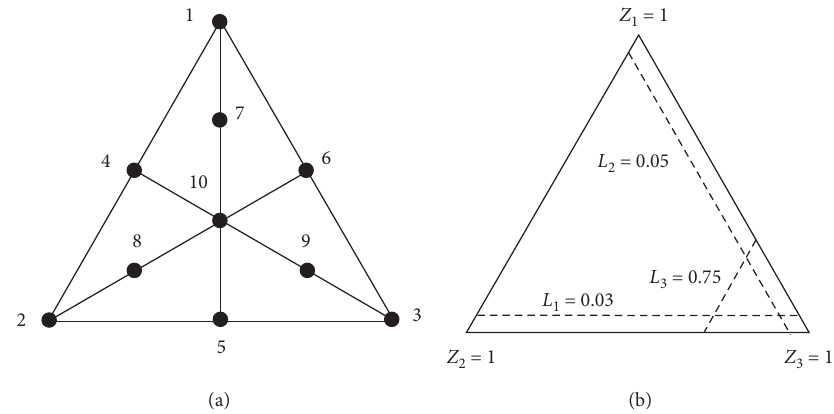
Figure 1: (a) Triangular simplex design test points. (b) Limited areas of cement, gravel, and raw soil content.